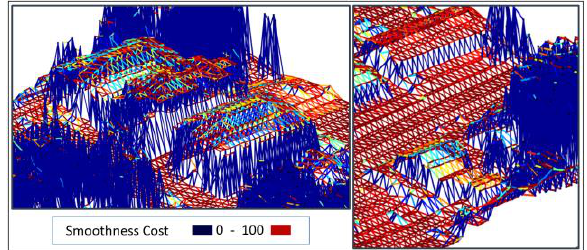
Figure 3. Example of smoothness costs for ground points.